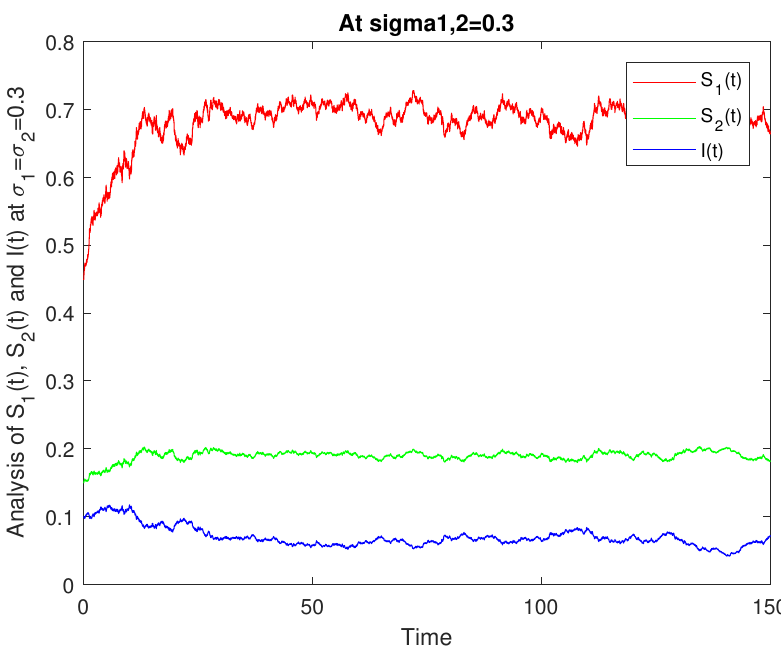
Figure 2. Numerical solution of the model (1) for σ 1 = σ 2 = 0.3.